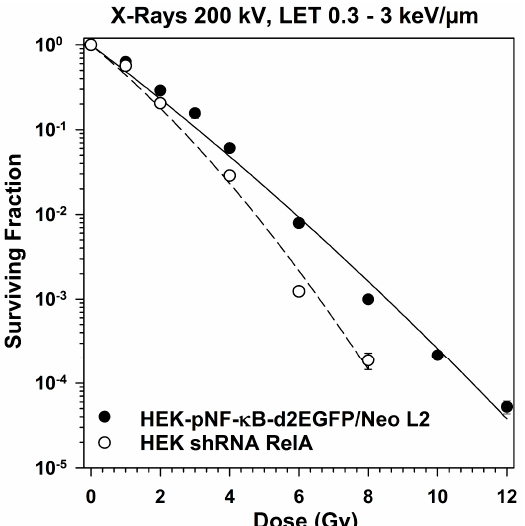
Figure 6. Clonogenic survival of HEK cells with RelA knock-down compared to the parental cells after X-irradiation (200 kV). HEK-pNF- κ B-d2EGFP/Neo L2 and HEK shRNA RelA cells were irradiated, incubated and colonies were fixed after 14 to 21 days (means ± SE of 7–13 independent experiments with six replicates each). Table 3. Parameters of the survival curves